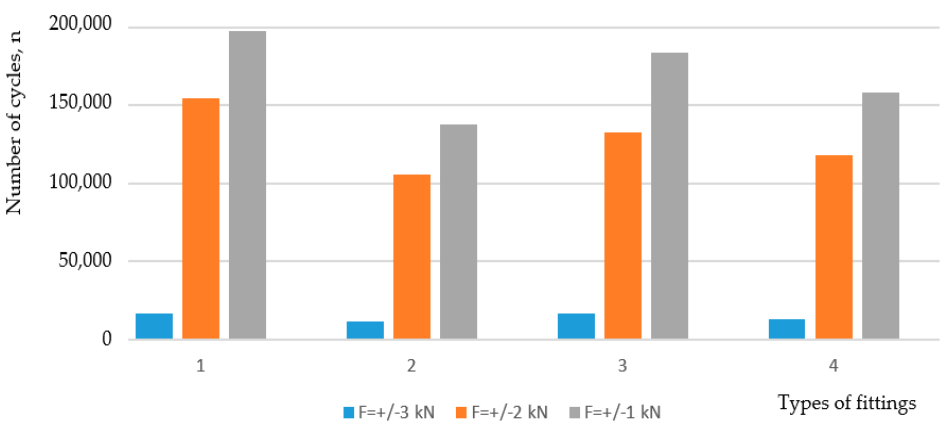
Figure 3. Graphical representation of the number of cycles until give in through fatigue. Also, by processing these experimental data, the durability curves were drawn in linear coordinates, Figure 4, as follows: for the T1 fitting—curve ∆ σ 1, for the T2 fittings— ∆ σ 2 curve, for the T3 fittings— ∆ σ 3 curve, for the T4 fittings— ∆ σ 4 curve.